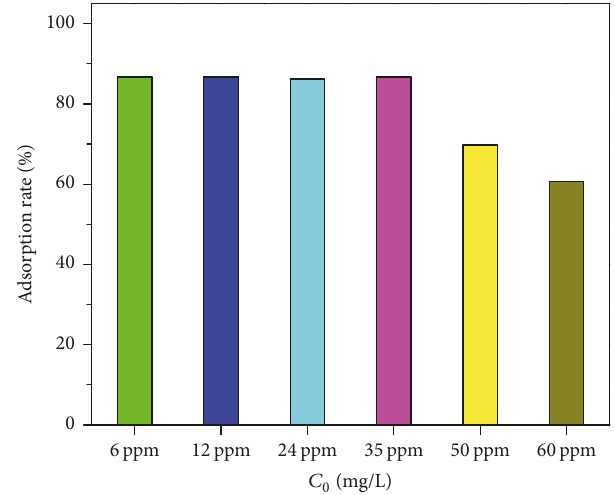
Figure 6: Removal efficiency (conditions: adsorption time, 24 h; initial concentration of solution, 6–60 mg/L; amount of adsorbent, 1.0 g/L; pH =